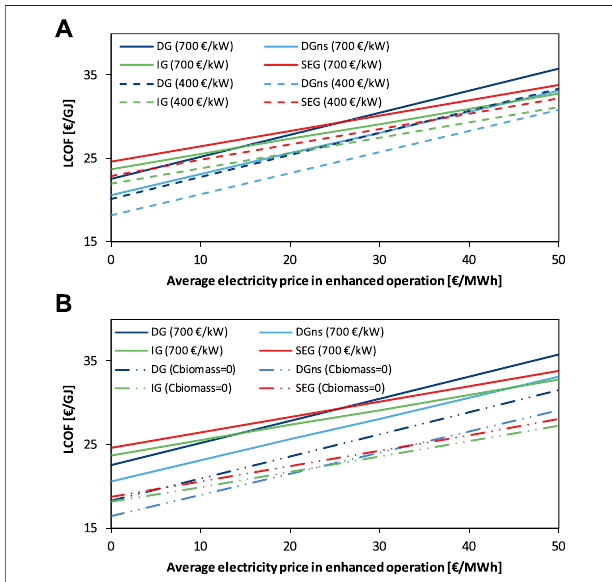
FIGURE 8 | LCOF as a function of the average electricity price in the enhanced operation for (A) different electrolysis cost (i.e., 700 vs . 400 € /kW) and (B) different biomass cost (i.e., 46 € /t vs. 0 € /t).